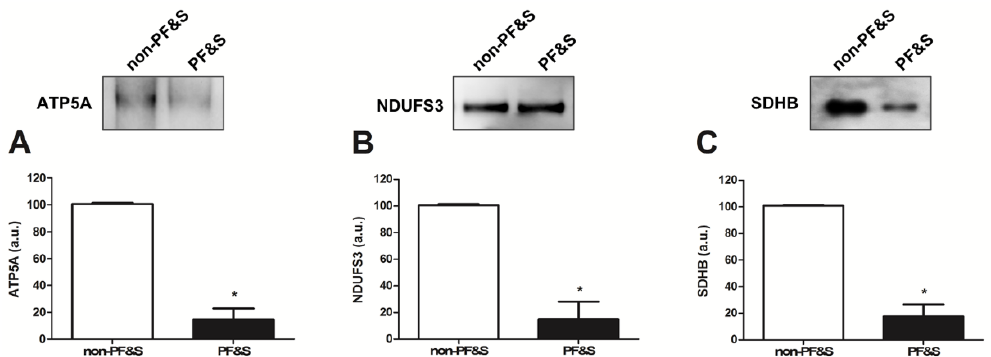
Figure 4. Protein expression of ( A ) adenosine triphosphate 5A (ATP5A), ( B ) nicotinamide adenine dinucleotidereduced form(NADH):ubiquinone oxidoreductase subunitS3 (NDUFS3), and ( C )succinate dehydrogenase complex iron sulfur subunit (SDHB) in purified small extracellular vesicles (sEVs) from non-physically frail non-sarcopenic (non-PF&S) controls (n = 10) and participants with physical frailty and sarcopenia (PF&S; n = 11). Data were normalized for the amount of sEV total proteins and are shown as percentage of the control group set at 100%. Bars represent mean values ( ± standard error of the mean). * p < 0.0001 versus non-PF&S.